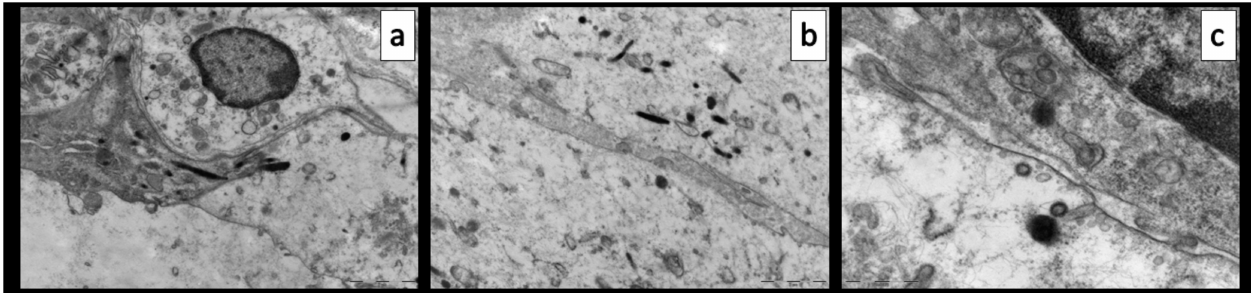
Figure 3. Transmission electron microscopy of the case report. ( a ) Endothelialitis, clear cytoplasm, hypertrophy of Golgi com- plex and abundance of Weibel–Palade bodies. ( b ) Junctional leakage. ( c ) Virus-like particles with fuzzy proteinaceous